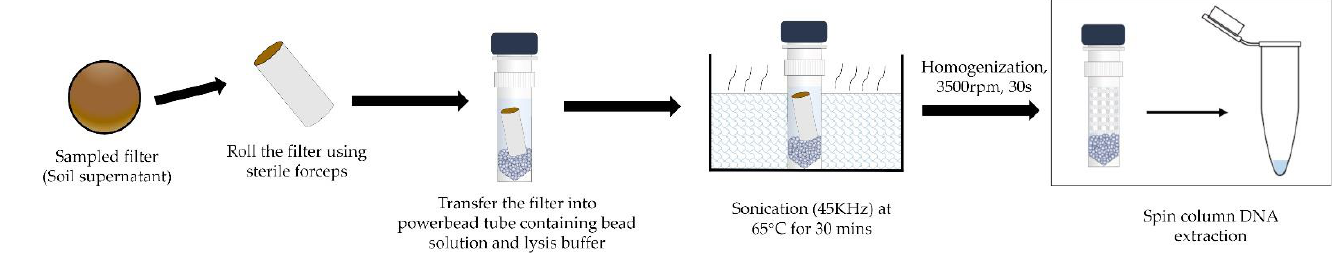
Figure 3. Summary of the optimised DNA extraction protocol from steps 1–4. The sonication of the sampled filter in a warm bath and bead beating are the key steps in the extraction process as they significantly improve the extraction efficiency.